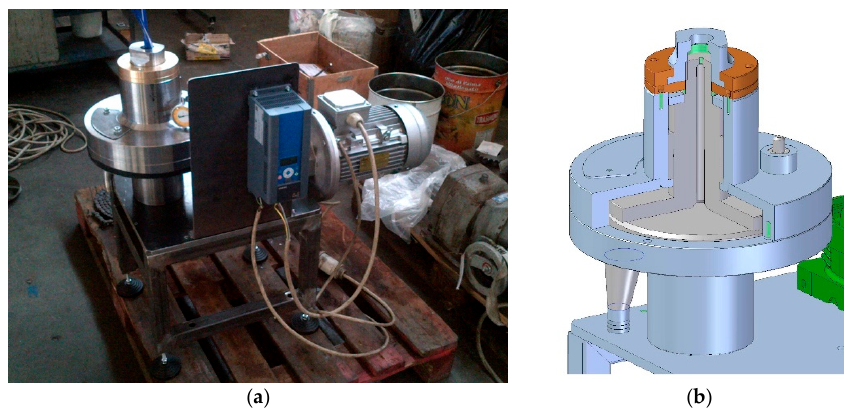
Figure 1. View of the CNT dispersion apparatus ( a ) and its internal schematics ( b ).